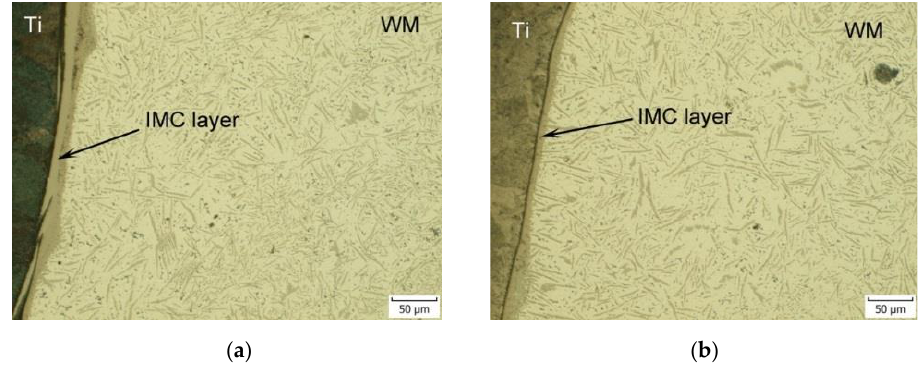
Figure 15. Ti Grade 2 — weld metal interface for ( a ) sample 2 and ( b ) sample 4 produced at laser powers of 2000 W and 1800 W, respectively. powers of 2000 W and 1800 W,